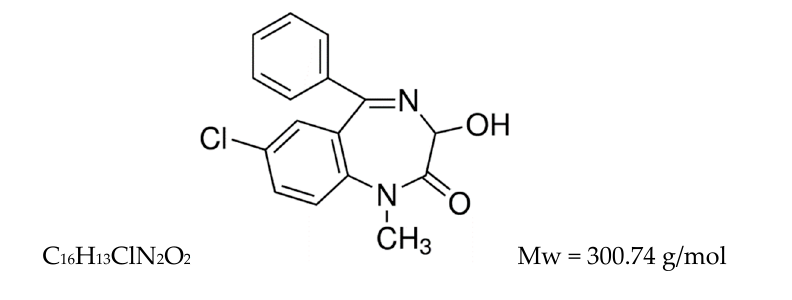
Figure 1. Chemical structure of temazepam.